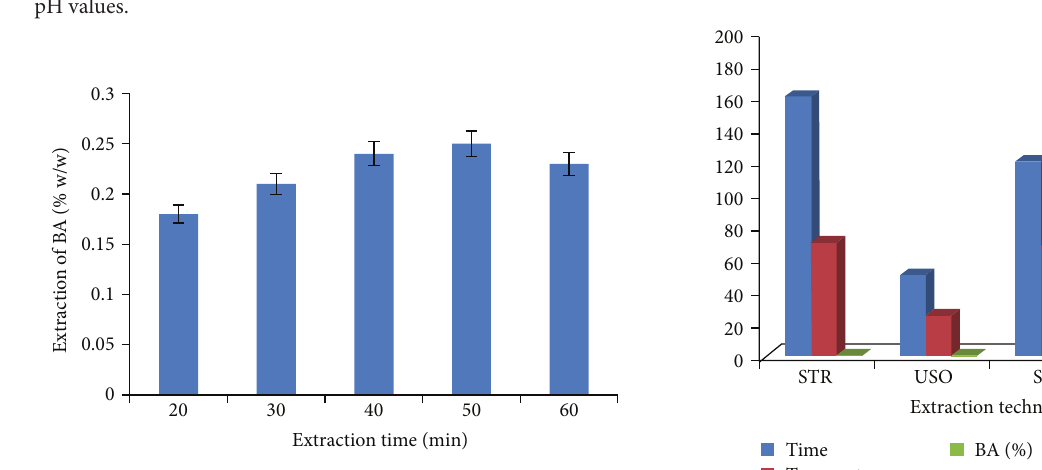
Figure 10: The effect of ultrasonic extraction time on percentage extraction of BA.